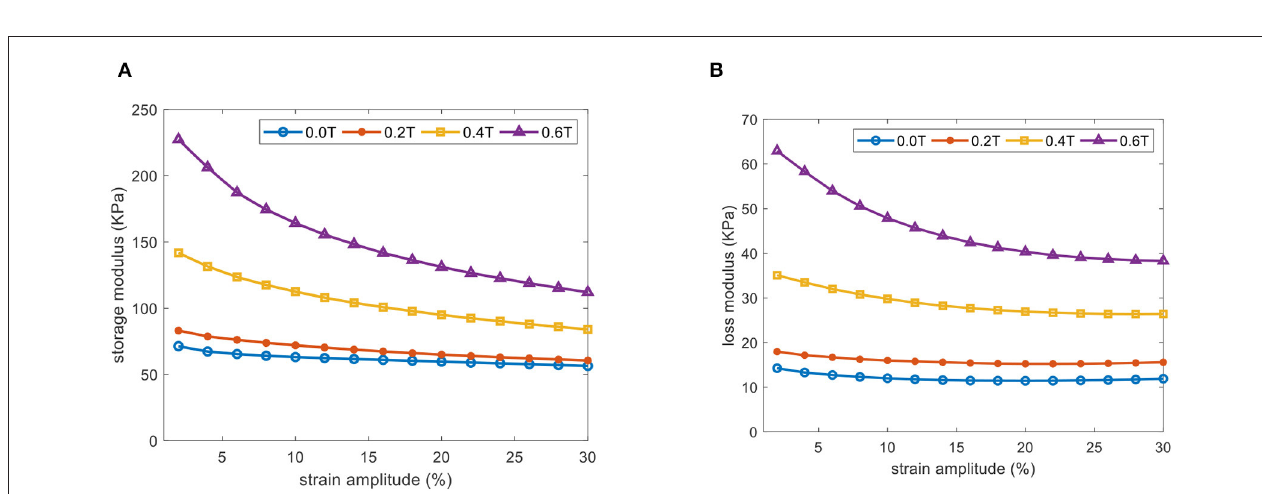
FIGURE 4 | (A) Storage and (B) loss moduli with respect to shear strain amplitudes under various levels of applied magnetic flux density and fixed frequency of 2Hz.